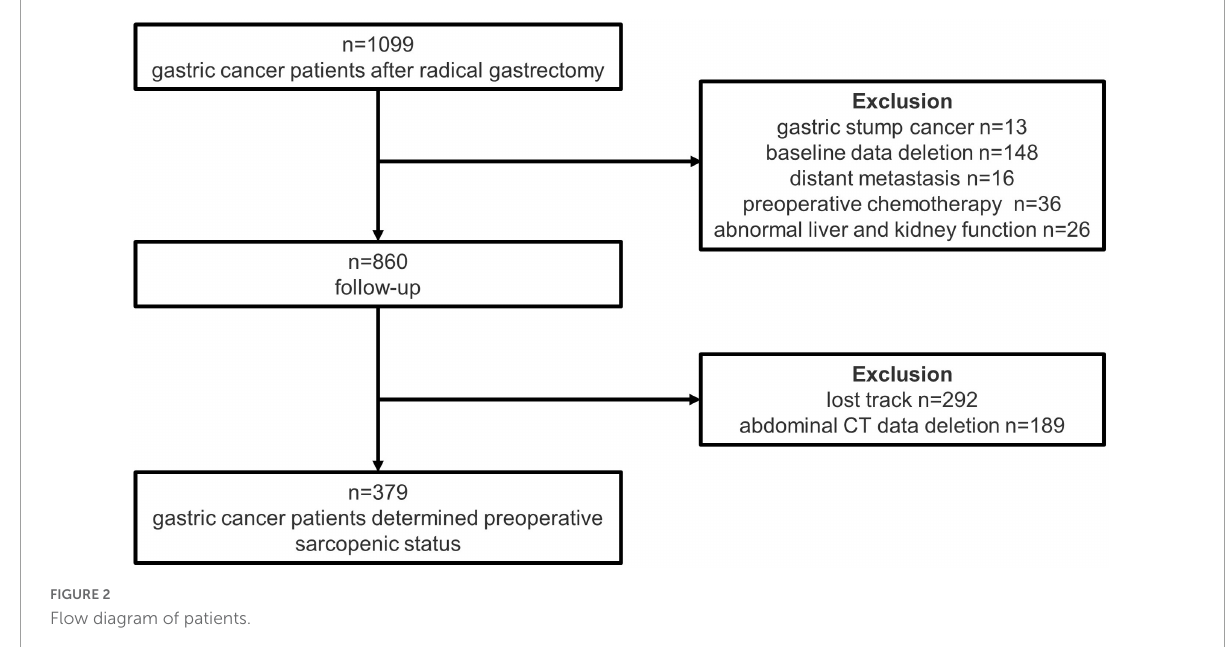
FIGURE2 Flow diagram of patients.